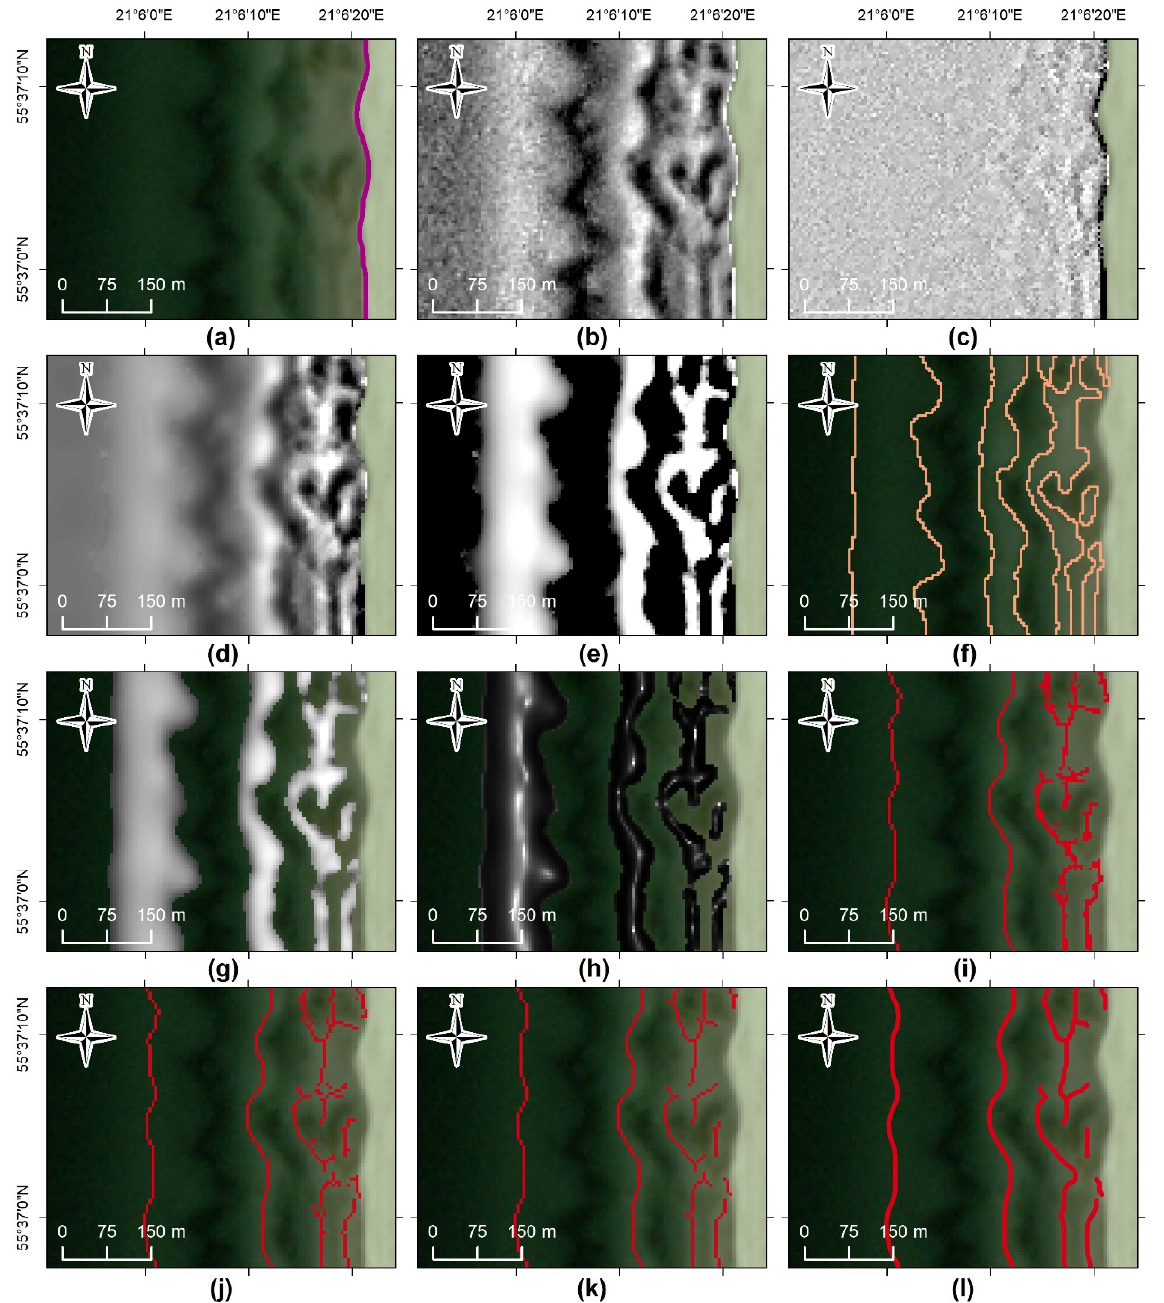
Figure 6. Examples of outputs at different stages of the proposed algorithm for PlanetScope imagery: ( a ) shoreline extracted after land-sea masking procedure; ( b ) multiscale RBPI Raster; ( c ) Curvature Raster; ( d ) Final RBPI-Curvature Raster; ( e ) Rescaled RBPI-Curvature Raster; ( f ) Bar Mask; ( g ) Final Bar Raster; ( h ) Bar-Slope Raster; ( i ) Primary Bar Crest Raster; ( j ) Secondary Bar Crest Raster; ( k ) Final Bar Crest Raster; ( l ) Final Bar Crest Polyline.